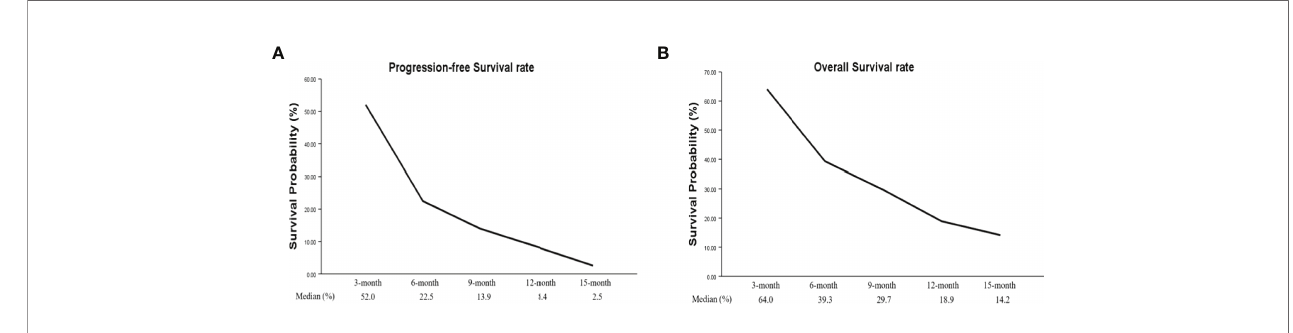
FIGURE 4 | Tendency chart of pooled PFS rate (3 – 15 months, A ) and pooled OS rate (3 – 15 months, B